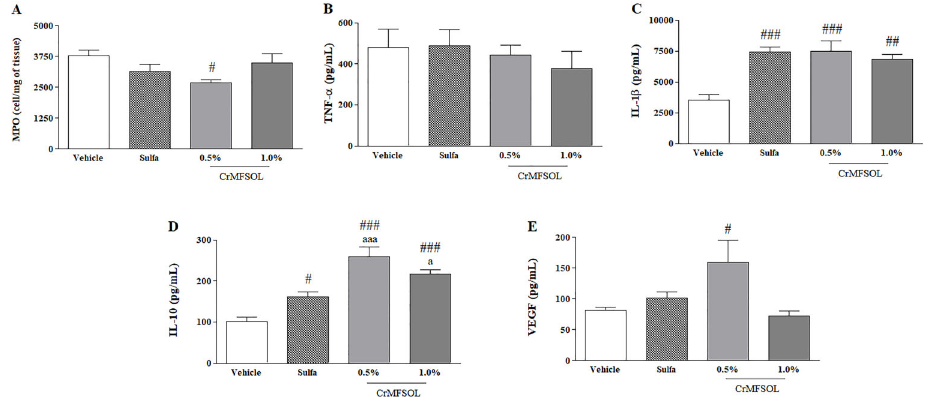
Figure 6. The treatment with methanol fraction of Sideroxylon obtusifolium cream (CrMFSOL) reduced myeloperoxidase activity (MPO) and stimulated release of interleukin (IL)-1 b and IL-10 after 3 days, and vascular endothelial growth factor (VEGF) after 14 days. The levels of tumor necrosis factor (TNF)- a were not reduced signi fi cantly. The data are reported as mean ± SE. # P o 0.05, ## P o 0.01, ### P o 0.001 compared to the Vehicle group; a P o 0.05 and aaa P o 0.001 compared to the Sulfa group n=6 animals/group per day) (one-way ANOVA followed by the Tukey